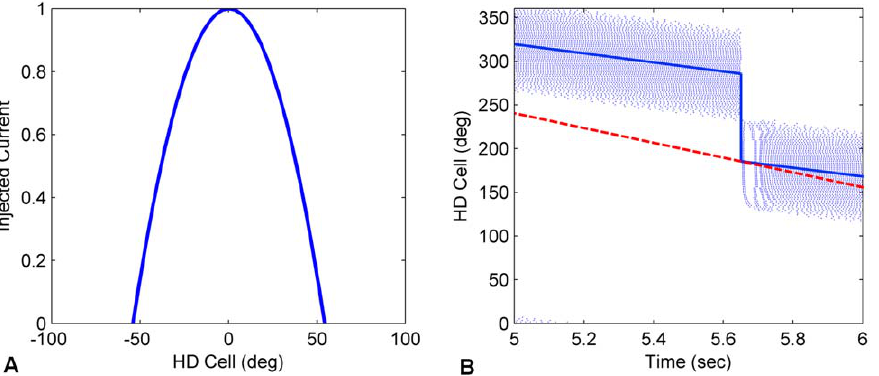
Figure 3. Landmark reset. (A) The activity template injected into the HDAAN when a landmark is recognised. The template shows the maximum current injected when the head is facing the landmark exactly; injected current falls to zero when the head deviates from the landmark by more than 6 3 degrees. (B) The HD bump position being updated by the landmark input during a head turn. Each dot represents a spike of an HD neuron. The solid blue line tracks the centre of the HD activity bump, which corresponds to the head direction represented by the network. The dashed red line tracks the actual head angle of the head. At time 5.65 secs the head reaches the landmark at 180 u but the HD network is trailing behind (turning too slowly). The injected landmark reset current resets the head direction representation to the landmark position, from where the turn